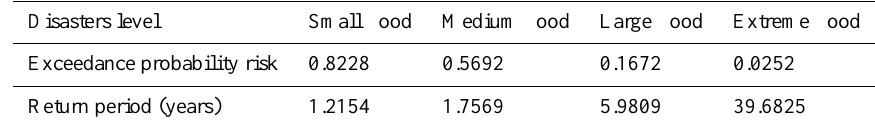
Table 9. Average divergence and the relative error for N( 0 , 1 ) .